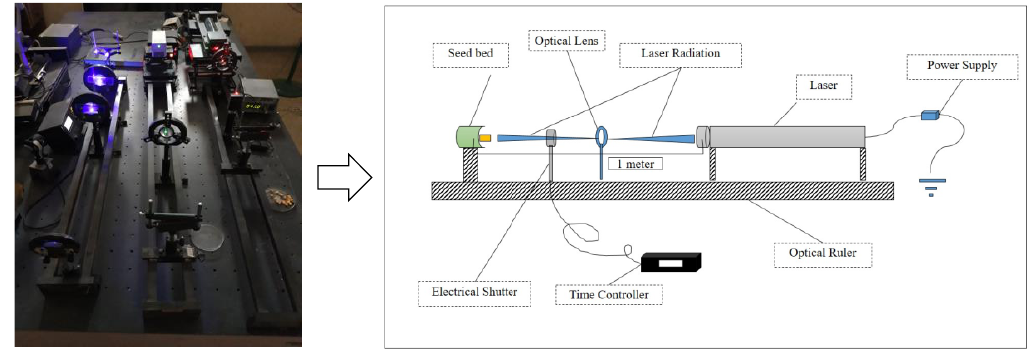
Figure 2. Set structure for the laser irradiation on maize seeds.